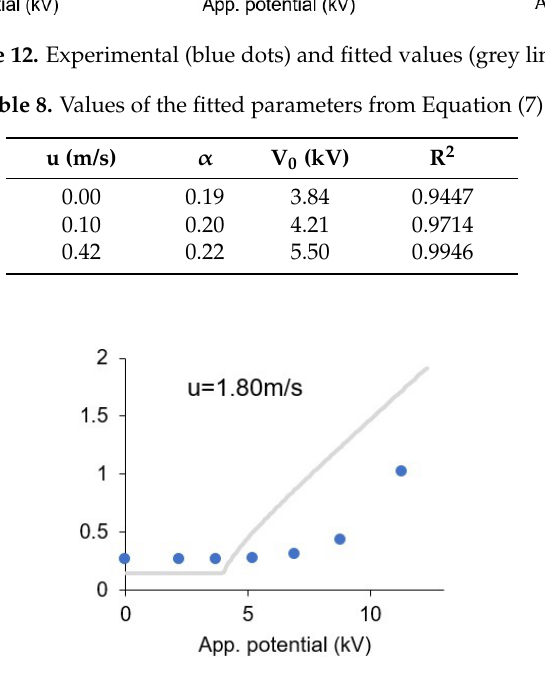
Figure 13. Comparison between the experimental data at u = 1.8 m/s (blue dots) and the fit at u = 0 (grey line).